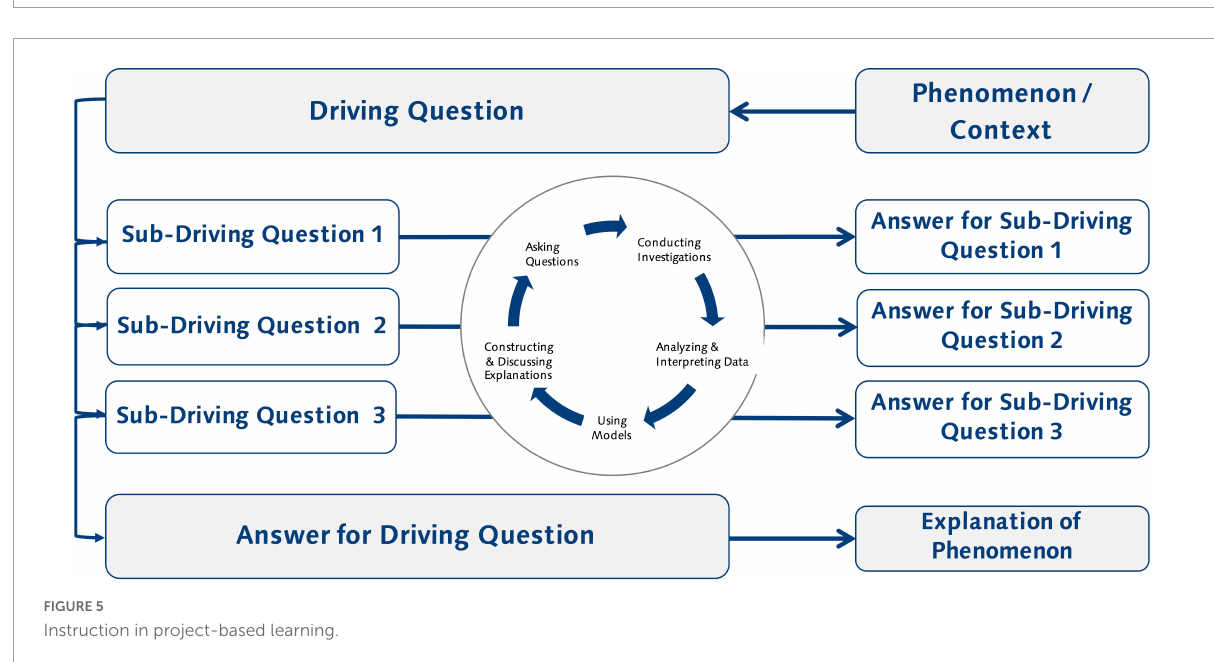
FIGURE5 Instruction in project-based